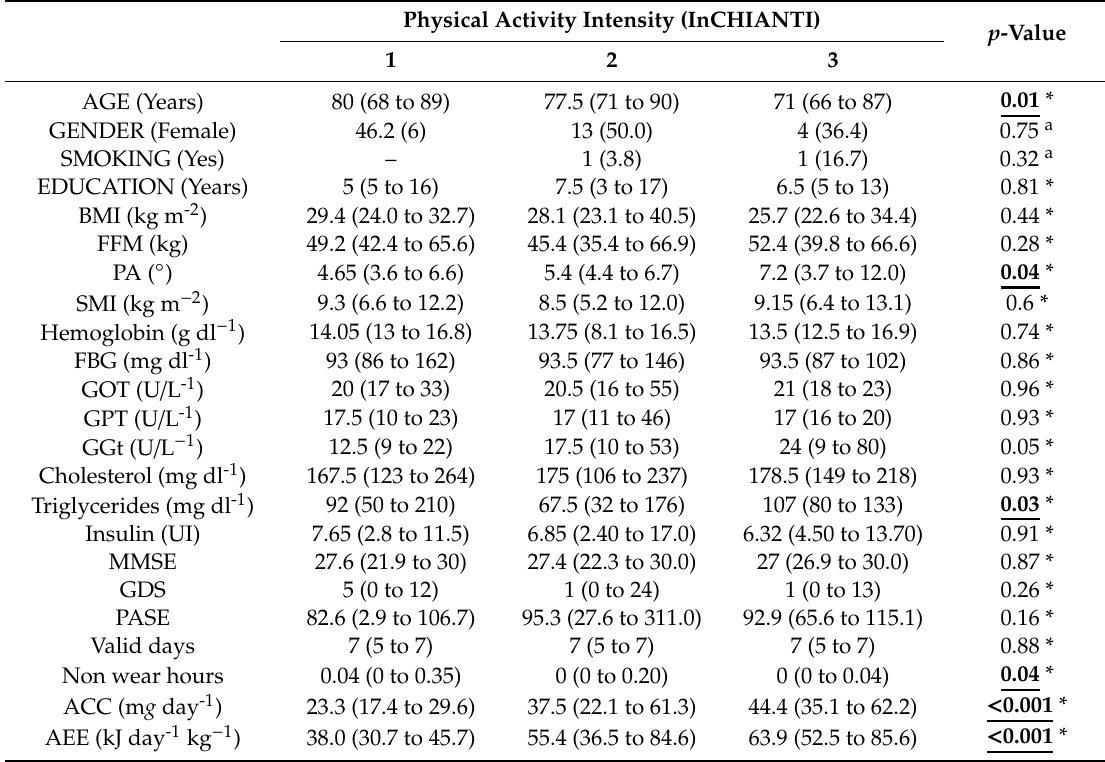
Table 2. Description of sociodemographic variables, metabolic biomarkers, neuropsychological status and general accelerometer-based PA parameters according to the InCHIANTI classification.